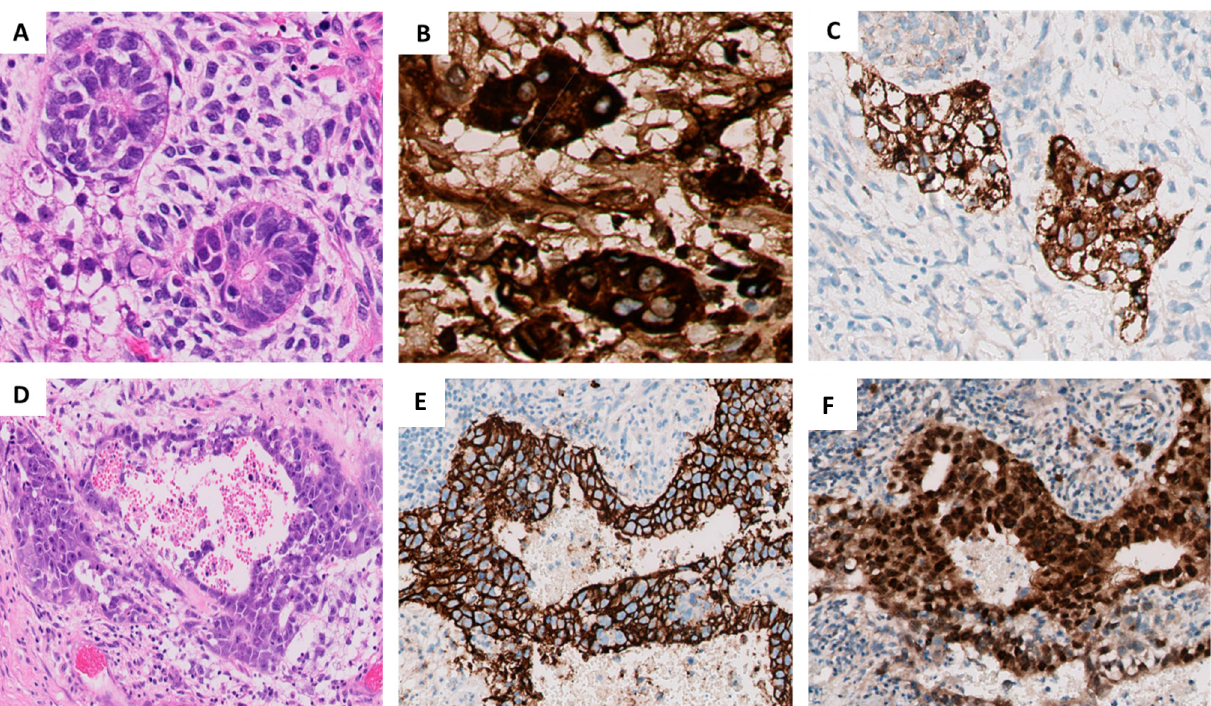
Figure 1. Hematoxylin-eosin (H and E) stains and immunohistochemistry of the primary mediastinal germ-cell tumor: ( A ) H and E of the YST component showing a prominent characteristic Schiller-Duval body (magnification 20×); ( B ) AFP immunostaining showing positive staining in the YST component (magnification 20×); ( C ) Glypican-3 immunostaining showing positive staining in the YST component (magnification 20×); ( D ) H and E of the EC (magnification 10×); and respective immunostaining for ( E ) CD30 and ( F ) OCT3/4 (magnification 10×).